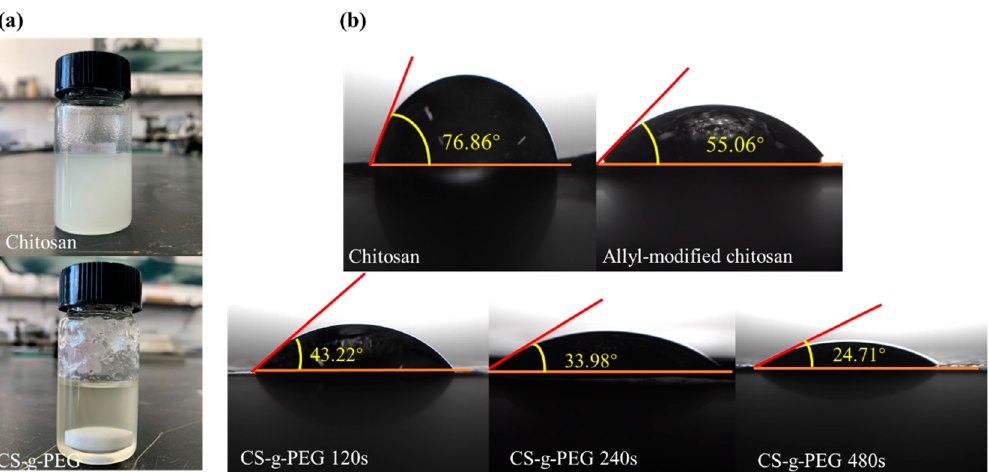
Figure 3. ( a ) Photographs of chitosan and CS-g-PEG dissolved in DMSO. ( b ) Contact angle measurements between liquid electrolyte and chitosan, allyl-chitosan and CS-g-PEG 120, 240 and 480 films. Table 1. Elemental analysis of allyl-chitosan and CS-g-PEG 120, 240 and 480.